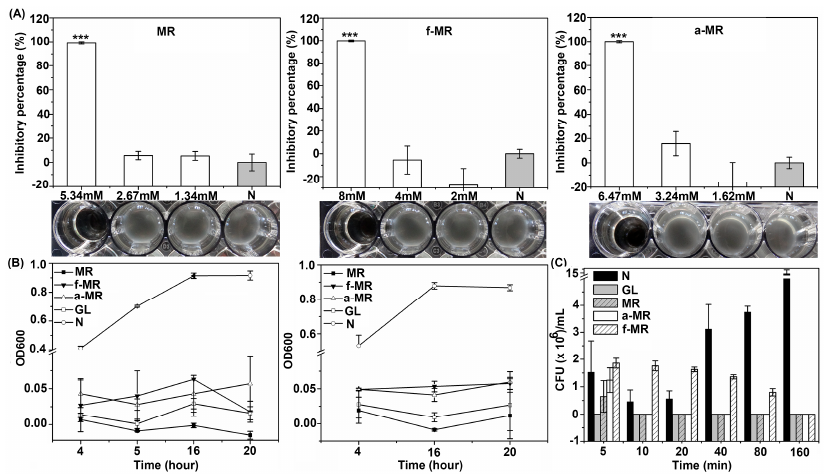
Figure 3. The cell growth of E. coli BL21 in the presence of peptides is shown. ( A ) The results of the broth macrodilution method used to determine the lethal concentration of peptides are shown. Results are mean values ± standard deviation (SD) of three independent experiments; ( B ) the OD600 of groups was changed along with time at their lethal concentration. Into each well of a 48-well plate was added 50 μ L of each lethal concentration of peptides and 50 μ L of E. coli BL21 (1 × 10 6 CFU/mL) in LTM. The plate was incubated at 37 °C for 3 h. Then 0.9 mL MHB was added to incubate at 37 °C for 4, 5, 16, and 20 h. Ten microliters were then transferred from the lethal concentration wells to centrifuge tubes containing 2 mL MHB medium. The centrifuge tubes were incubated at 37 °C for 4, 16, and 20 h. GL is the positive control group at 2.1 mM. Results are mean values ± SD of three independent experiments; and ( C ) the result of killing kinetics assays is shown. MR and a-MR kill E. coli BL21 rapidly, while f-MR kills E. coli BL21 slowly. The bacteria were counted by CFU. Negative or positive controls were run without peptide or with GL. Results are mean values ± SD of three independent experiments. The symbol “N” represents the negative control group without peptides. Results are typical results of three separate experiments. *** α < 0.001 vs. control.